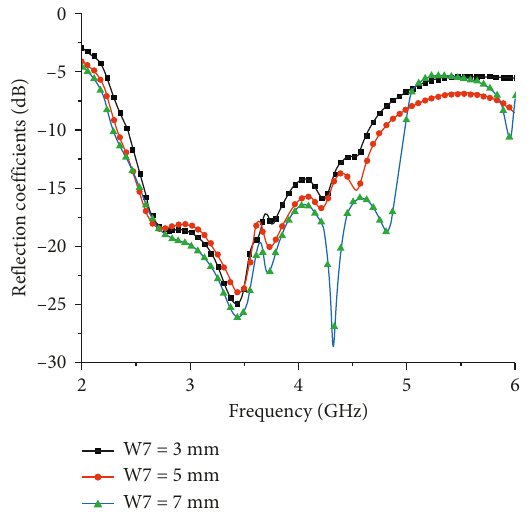
Figure 6: Simulated reflection coefficients of the proposed MIMO antenna with the varied width W7.